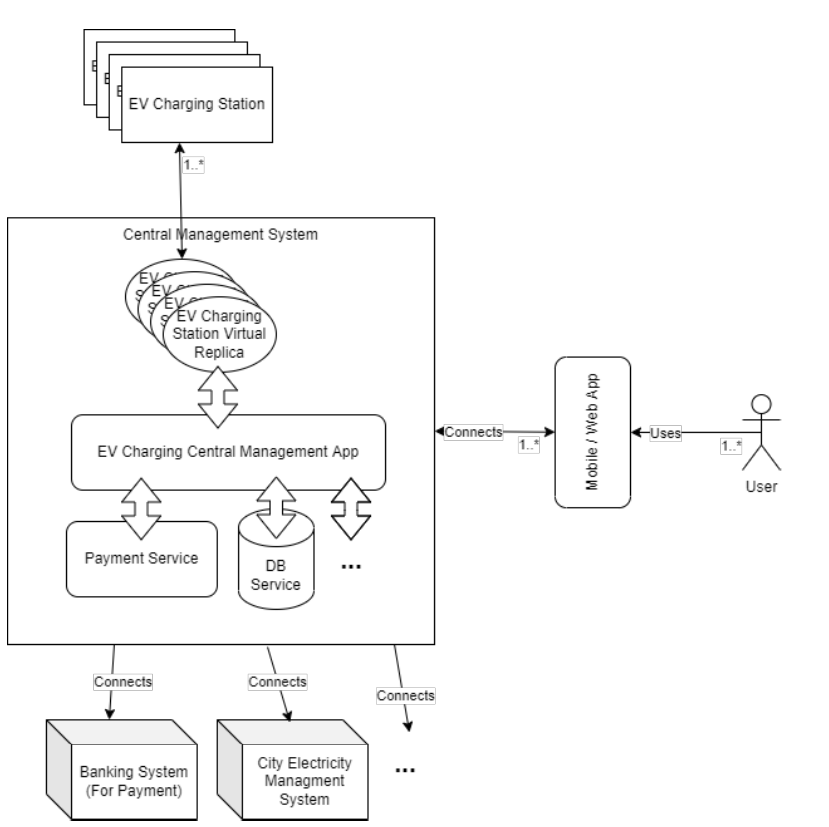
Figure 7. Conceptual diagram of Smart Charging System (1 and * stands for one-to-many relation) .